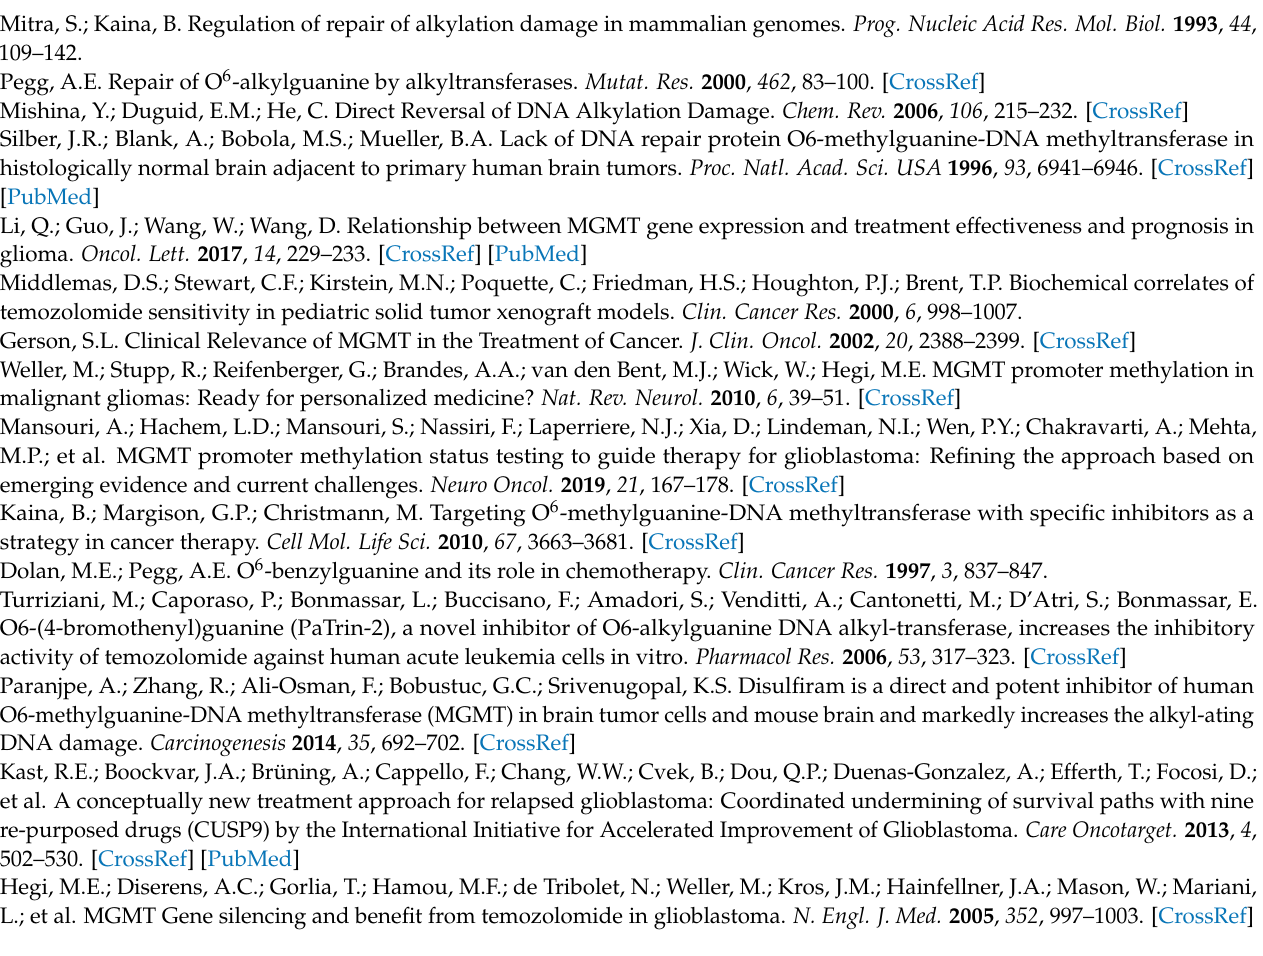
database. Figure S3: The CGI plots of original and revised MGMT promoters. Table S2: Genomic context of siRNA and shRNAs used in this study to target the CTCF